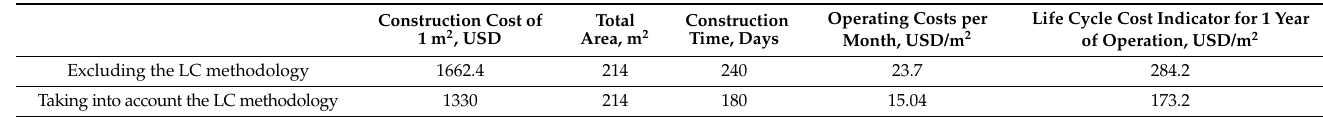
Table 11. Comparison of indicators for the period of the life